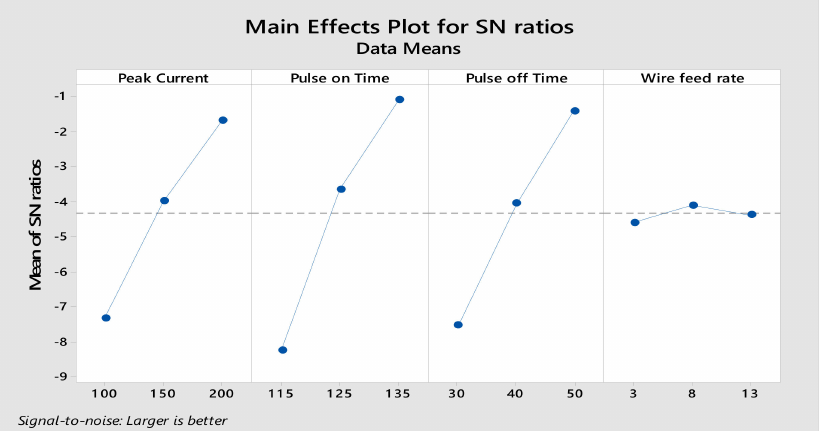
Figure 10. Main effects plot for